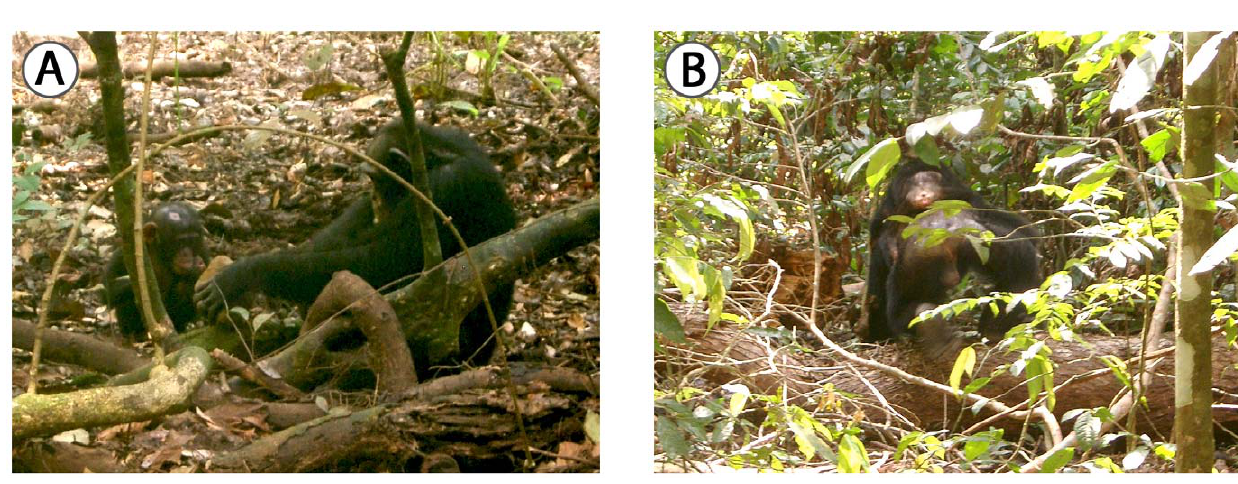
Figure 3. The adult male Porthos with his adopted female infant Gia. A) Porthos cracking and sharing nuts with Gia, B) Porthos carrying Gia on his back.